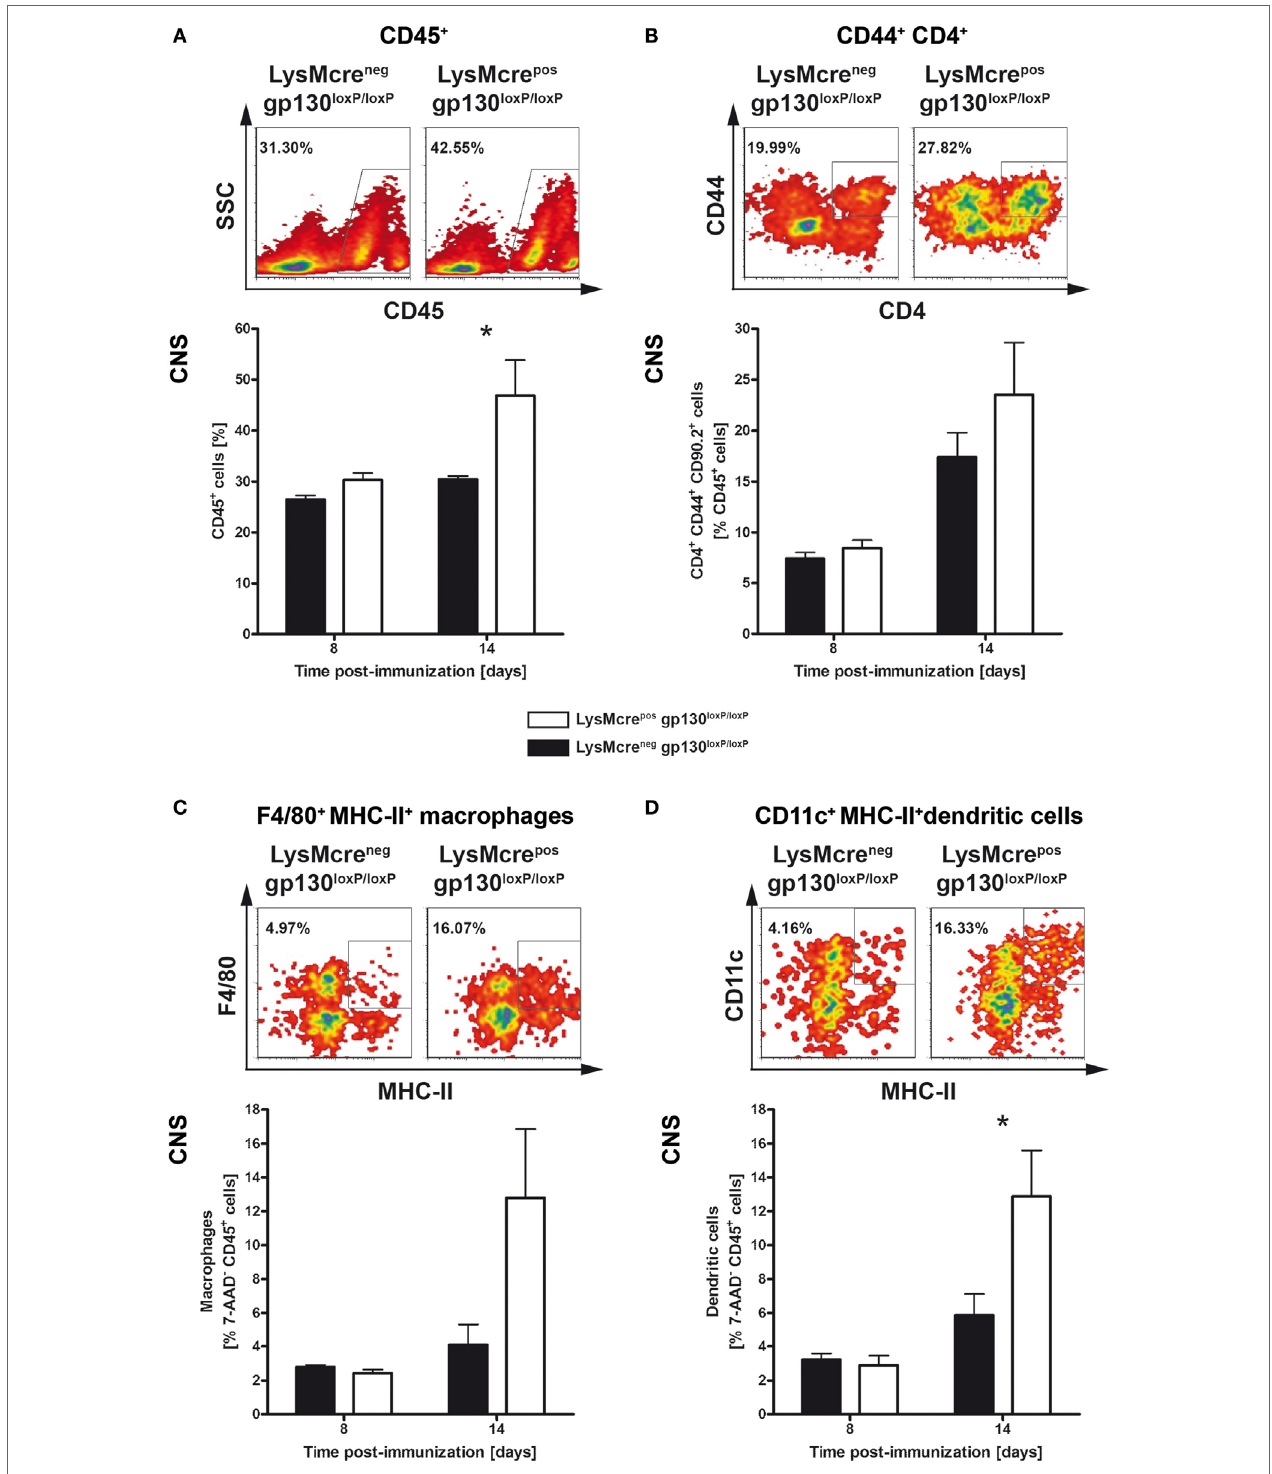
FigUre 6 | Characterization of infiltrates in immunized LysMcre pos gp130 loxP/loxP mice and LysMcre neg gp130 loxP/loxP mice. LysMcre pos gp130 loxP/loxP mice (white bars) and LysMcre neg gp130 loxP/loxP littermates (black bars) were immunized with MOG 35–55 /CFA. During the course of EAE, the frequency of (a) CD45 + lymphocytes, (B) activated CD44 + CD4 + T cells, (c) F4/80 + MHC-II + macrophages, and (D) CD11c + MHC-II + dendritic cells was determined by flow cytometry. For the analysis, single cell suspensions of CNS-infiltrating lymphocytes were performed at different time points. Representative flow cytometry density plots of cells isolated on day 14 are shown. Data represent means and SEs of five mice per group. Statistical analysis was performed using Mann–Whitney test. Asterisks indicate statistical significance (* p ≤